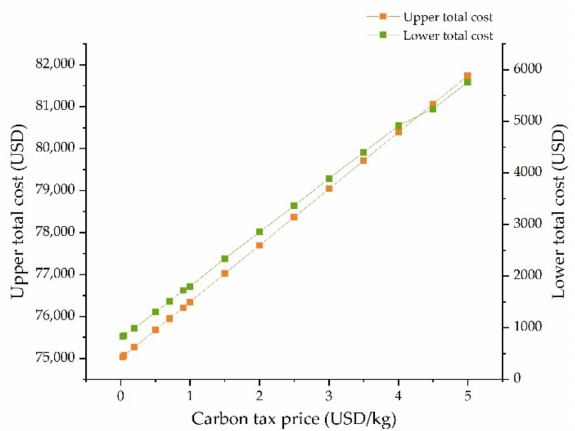
Figure 11. The relationship between the total cost of the upper and lower levels and carbon tax